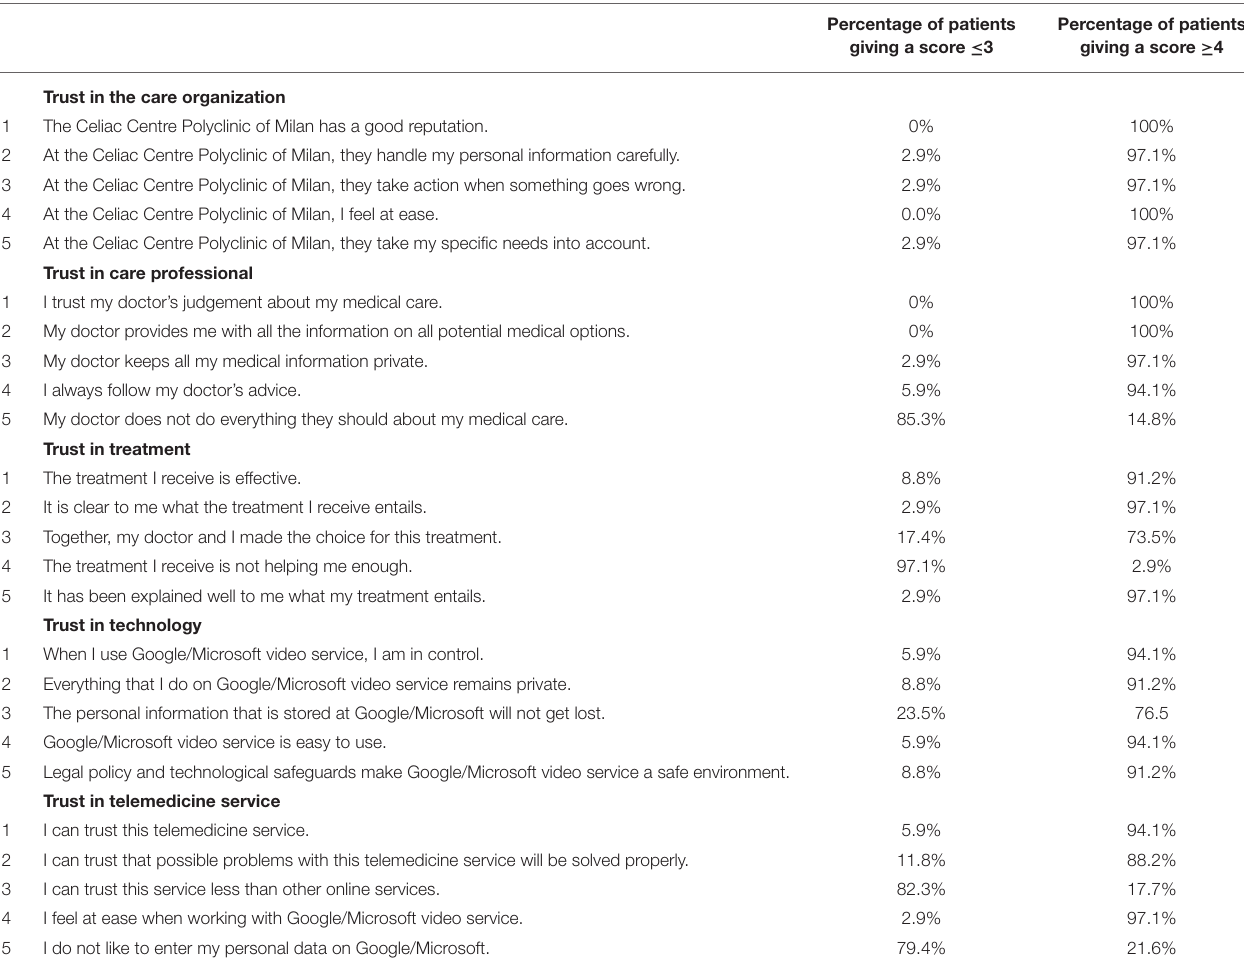
TABLE 2 | The patient trust assessment tool (PATAT) as responded by 34 CeD patients.